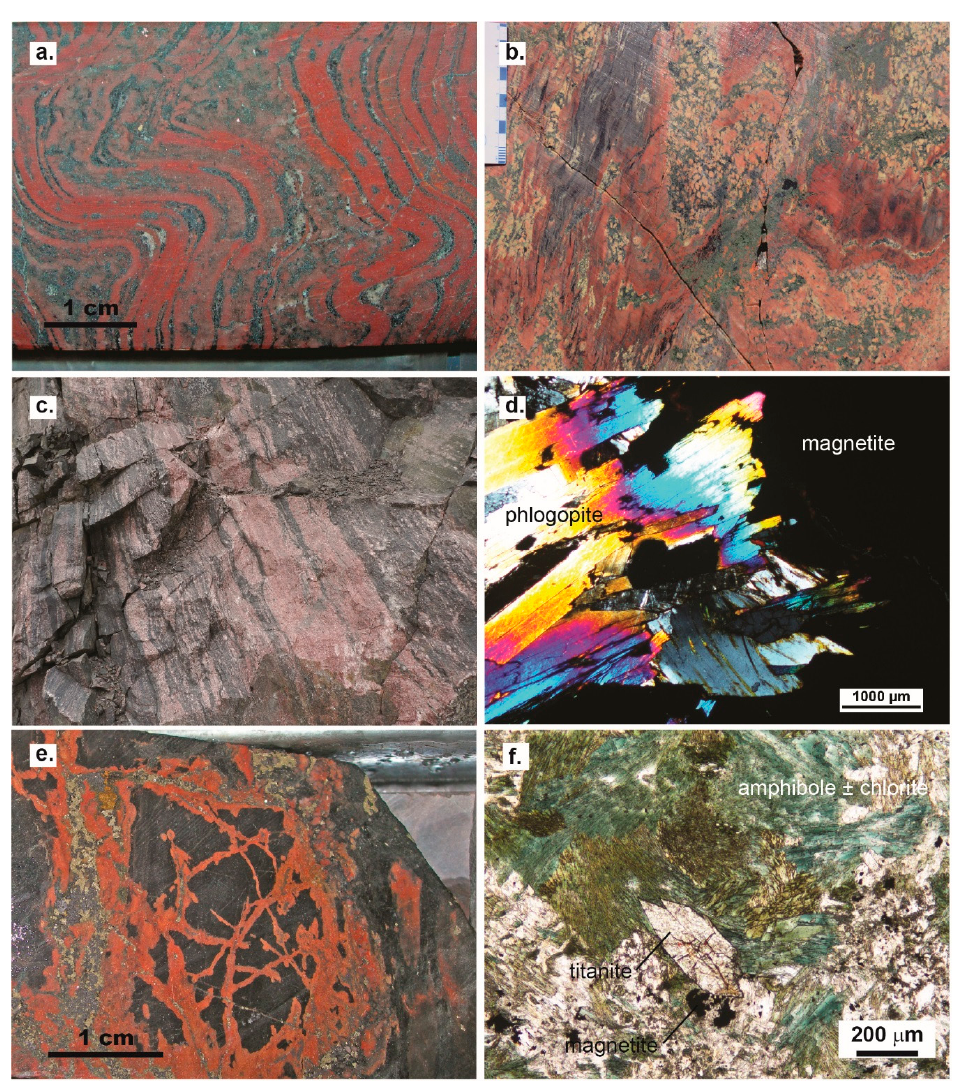
Figure 7. Examples of albite and magnetite-rich alteration assemblages from the Olympic Cu-Au Province. ( a ) Laminated albite-calc-silicate metasomatite, drill hole St Joe PB 12, 130 m. Fine layering suggests the protolith was metasedimentary. Albite is hematite-dusted and is red in colour. ( b ) Oorlano Metasomatite from near Wallaroo, Yorke Peninsula. Mineralogy includes albite, microcline, actinolite, magnetite and quartz, with the green coloured zones being richer in diopside, amphibole, epidote and magnetite, along with titanite, pyrite, apatite and hematite. Scapolite may also be present and magnetite is greater in abundance than hematite. ( c ) Magnetite-amphibole alteration at the Cairn Hill Fe-Cu deposit, Mount Woods district. Magnetite-amphibole ± biotite overprints granite gneiss and occurs parallel to the main tectonic foliation [126] . Field of view approximately 3 m wide. ( d ) Thin section photomicrograph of phlogopite-magnetite assemblage from Cairn Hill. Sample 1998157 from magnetite ore. ( e ) K-feldspar-hematite veins cross-cutting siltstone. Veining is associated with pyrite-chalcopyrite and very fine-grained white mica + hematite alteration. Drill hole MALD 1, ~131 m, Yorke Peninsula region. ( f ) Thin section photomicrograph of amphibole-chlorite-titanite alteration. Sample 1,833,361, drill hole AD8, 842.1 to 842.2 m.